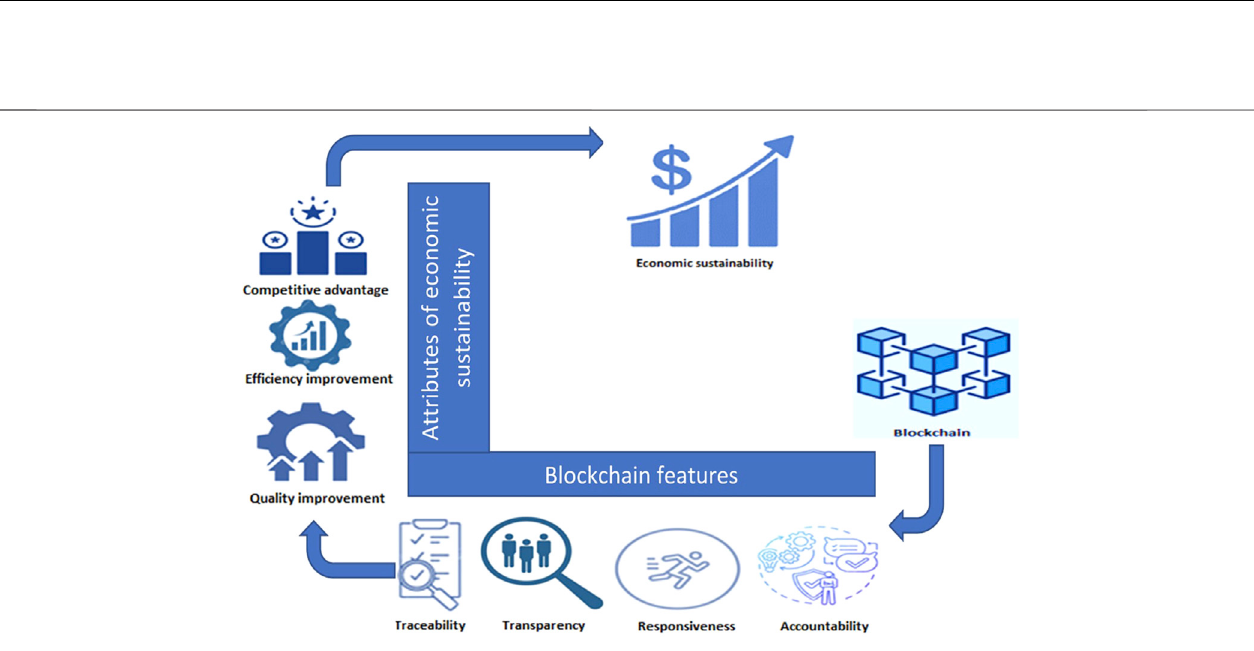
FIGURE 3 | Conceptual framework of economic sustainability of the supply chain through blockchain.